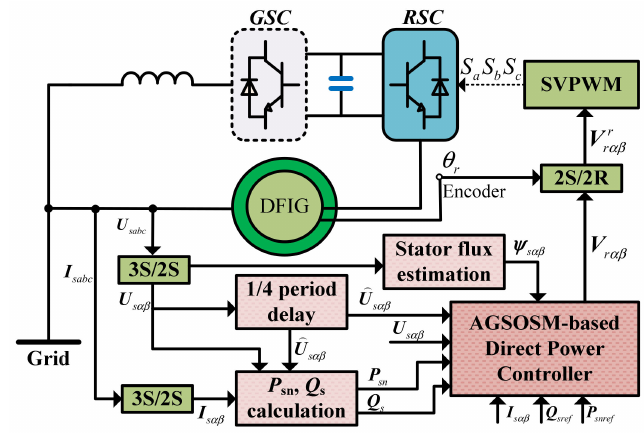
Figure 2. System control